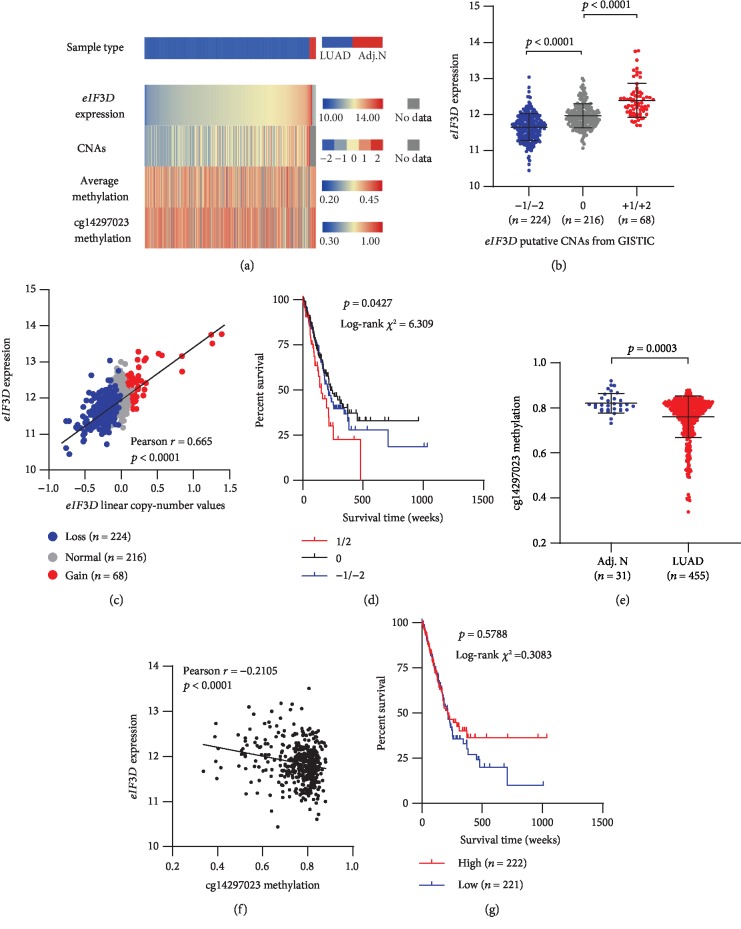
Copy number alterations and DNA methylation analysis of eIF3D in LUAD patients. (a) Heatmap showing eIF3D expression and corresponding DNA copy number alterations, averaged DNA methylation, and methylation in cg14297023. (b) Plot chart showing eIF3D expression in different CNA groups. (c) Linear regression analysis of the correlation between eIF3D expression and its linear copy number values. (d) Kaplan-Meier survival analysis of different eIF3D CNA levels for OS in patients with LUAD. (e) Plot chart showing DNA methylation of cg14297023 site in LUAD tissues and adjacent normal tissues. (f) Linear regression analysis of the correlation between cg14297023 methylation and eIF3D expression. (g) Kaplan-Meier survival analysis of different methylation levels in cg14297023 for OS in patients with LUAD. Adj. N: adjacent normal tissues; GISTIC: Genomic Identification of Significant Targets in Cancer [25].